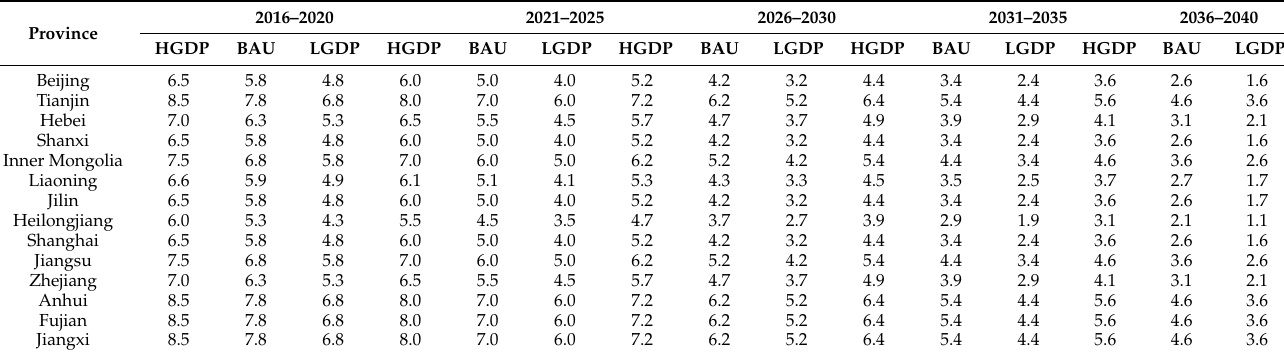
Table A4. Different scenarios of provinces’ GDP